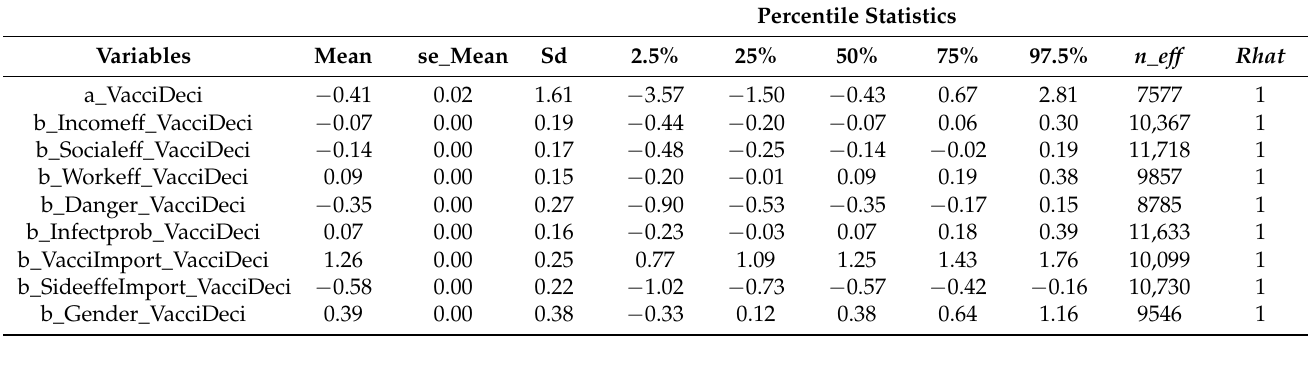
Table 5. Summary of the estimated coefficients from hierarchical Vaccination Decision model.